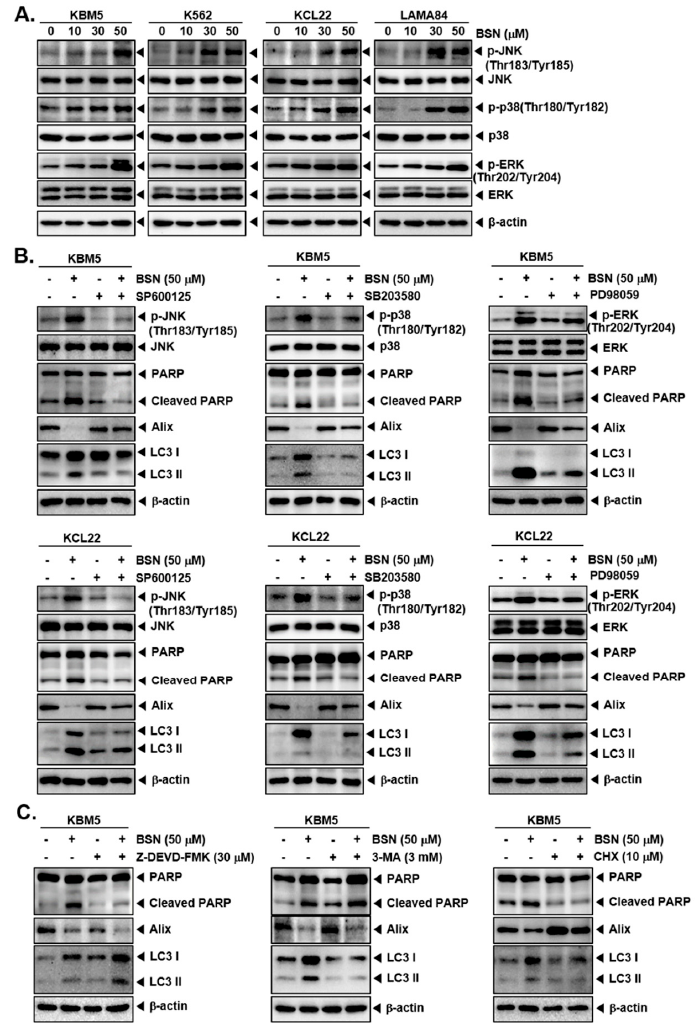
Figure 4. BSN activates MAPK signaling pathway. ( A ) KBM5, K562, KCL22, and LAMA84 cells were treated with BSN (0, 10, 15, 30, 50, 100 μ M) for 24 h and Western blotting was carried out. ( B ) The cells were treated with SP600125 (10 μ M) or SB203580 (10 μ M) or PD98059 (10 μ M) and treated with BSN (50 μ M) for 24 h. Western blot analysis was performed. ( C ) The cells were treated with Z-DEVD-FMMK (30 μ M) or 3-MA (3 mM) or CHX (10 μ M) and treated with BSN (50 μ M) for 24 h. Then, expressions of various proteins were evaluated by Western blot analysis. The results shown are representative of the three independent